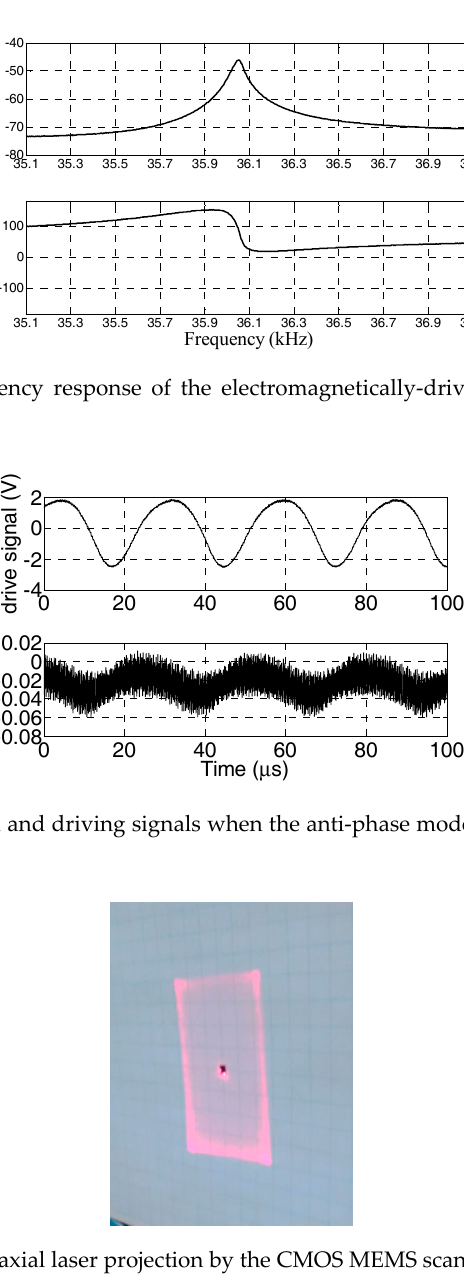
Figure 5. Measured mechanical modes of the CMOS MEMS scanner. The measured slow-axis and anti-phase fast-axis modes are 4.3 and 36.05 kHz, respectively.